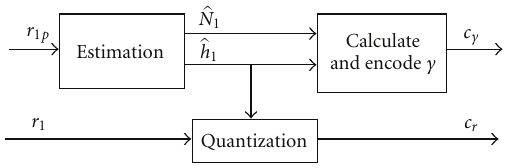
Figure 2: Schematic representation of the relay